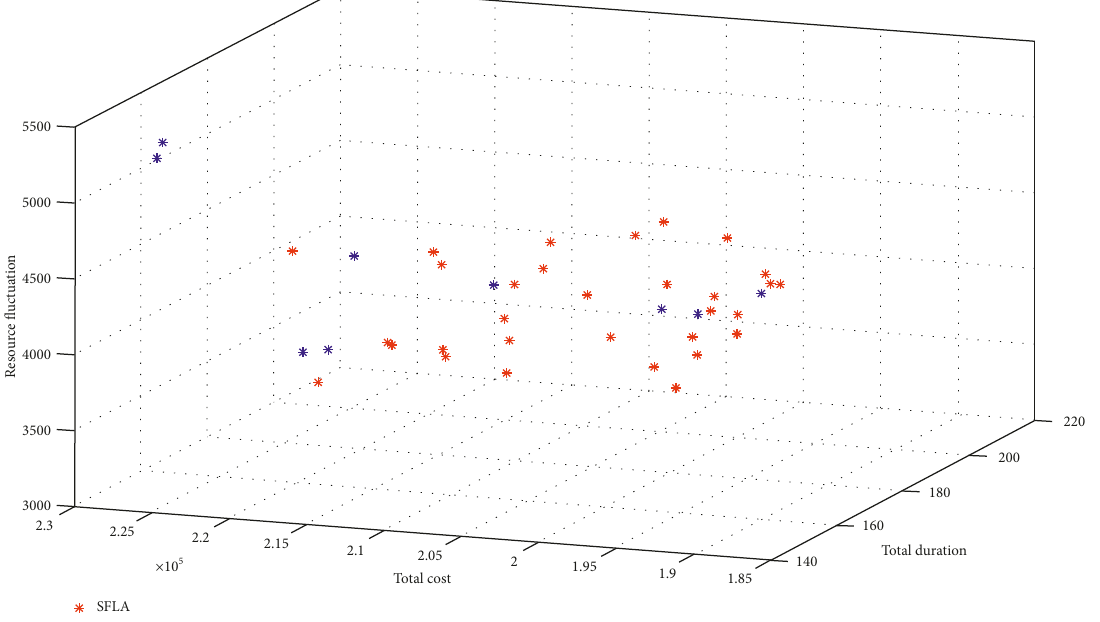
Figure 10: Optimal solutions generated by SFLA and NSGA